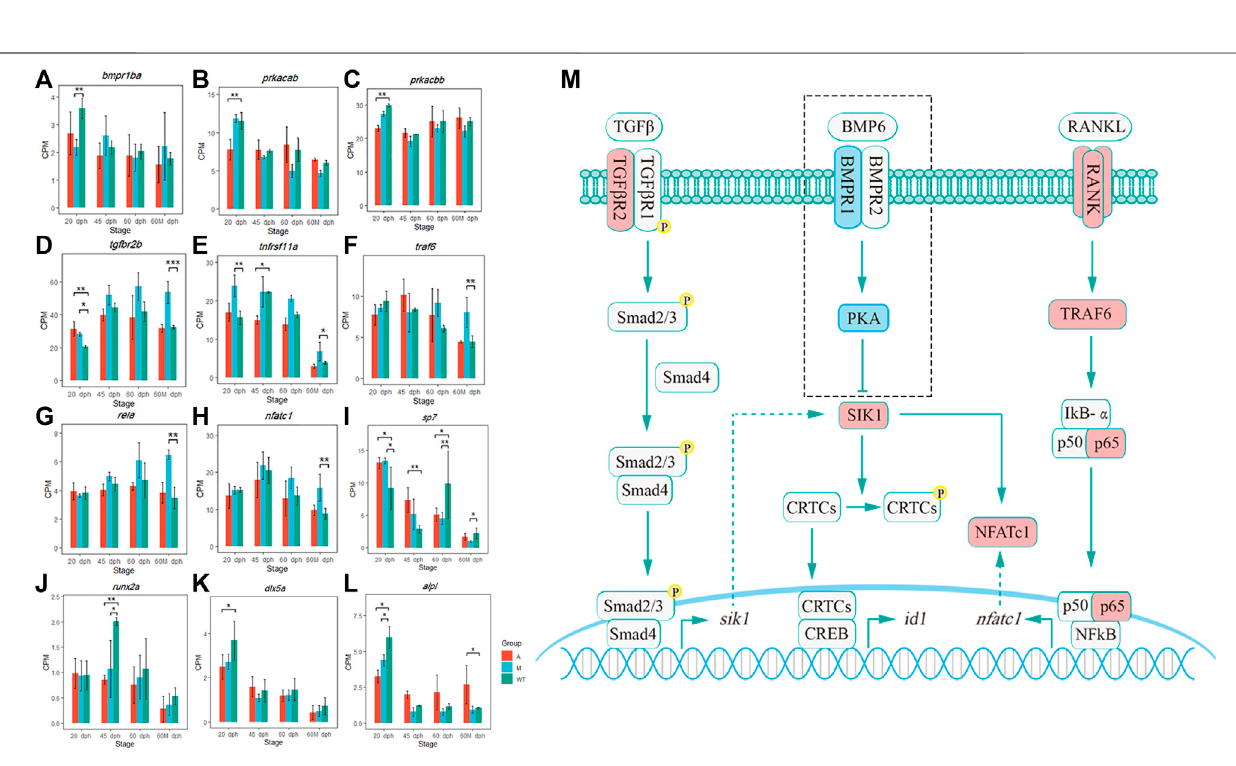
Frontiers in Cell and Developmental Biology |